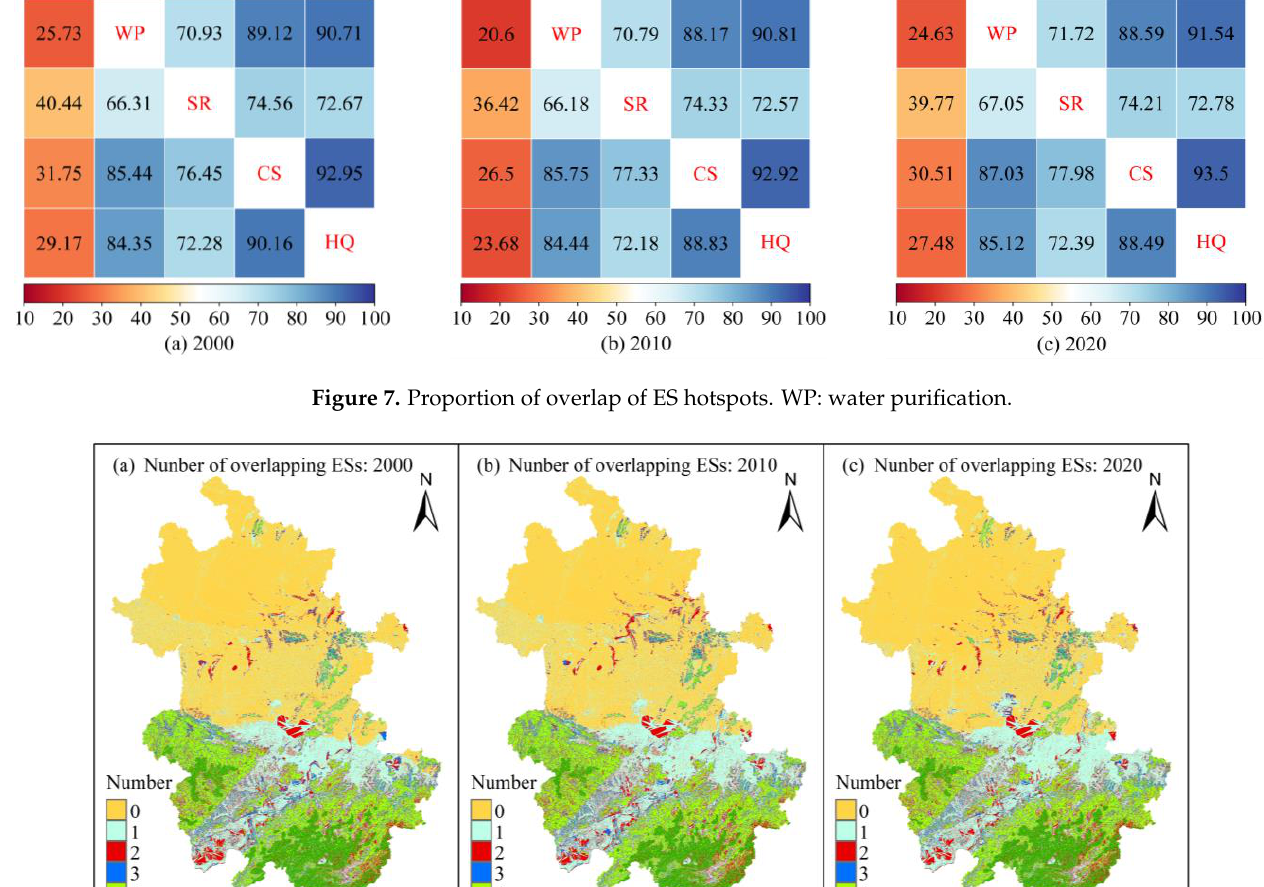
Figure 9. Results from the multi-scenario simulation for land use in 2030.